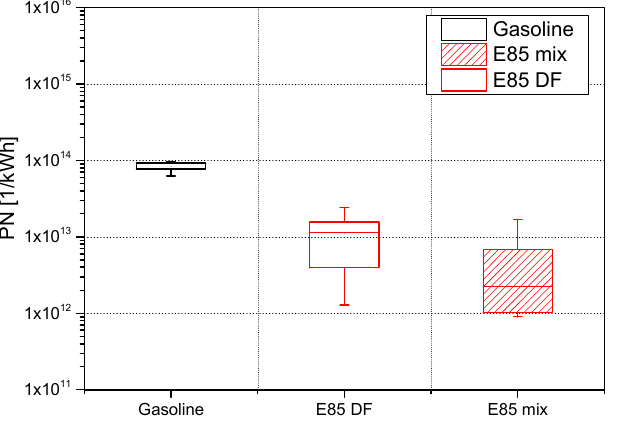
Figure 11. PN emissions displayed by box and whiskers plot.